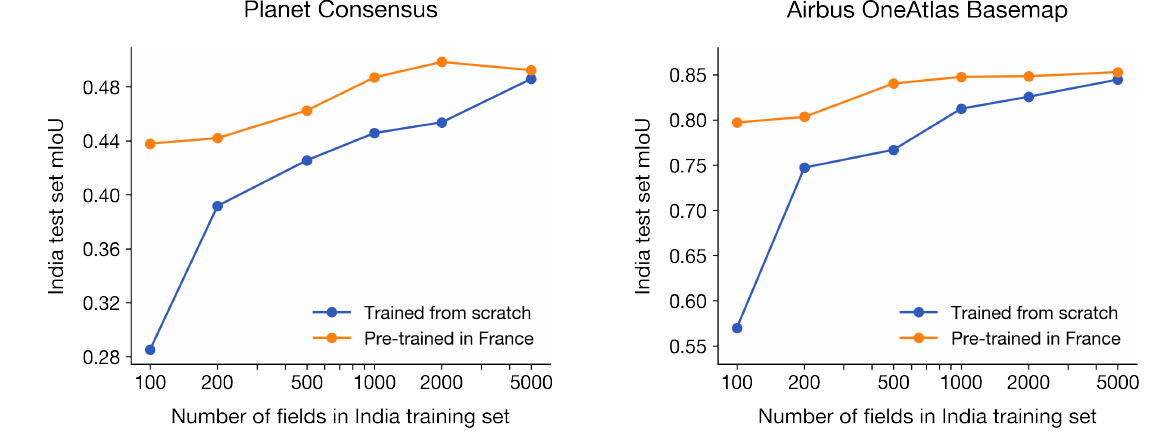
Figure 7. The effect of pre-training a model in France. We show the field delineation performance in India (measured by median intersection-over-union, mIoU) as we vary the number of labeled fields in the India training set for (left) a 3-month PlanetScope consensus and (right) Airbus SPOT imagery. As the number of training fields decreases, pre-training in France before fine-tuning on India fields confers more of a benefit over training a model from scratch on the India fields.